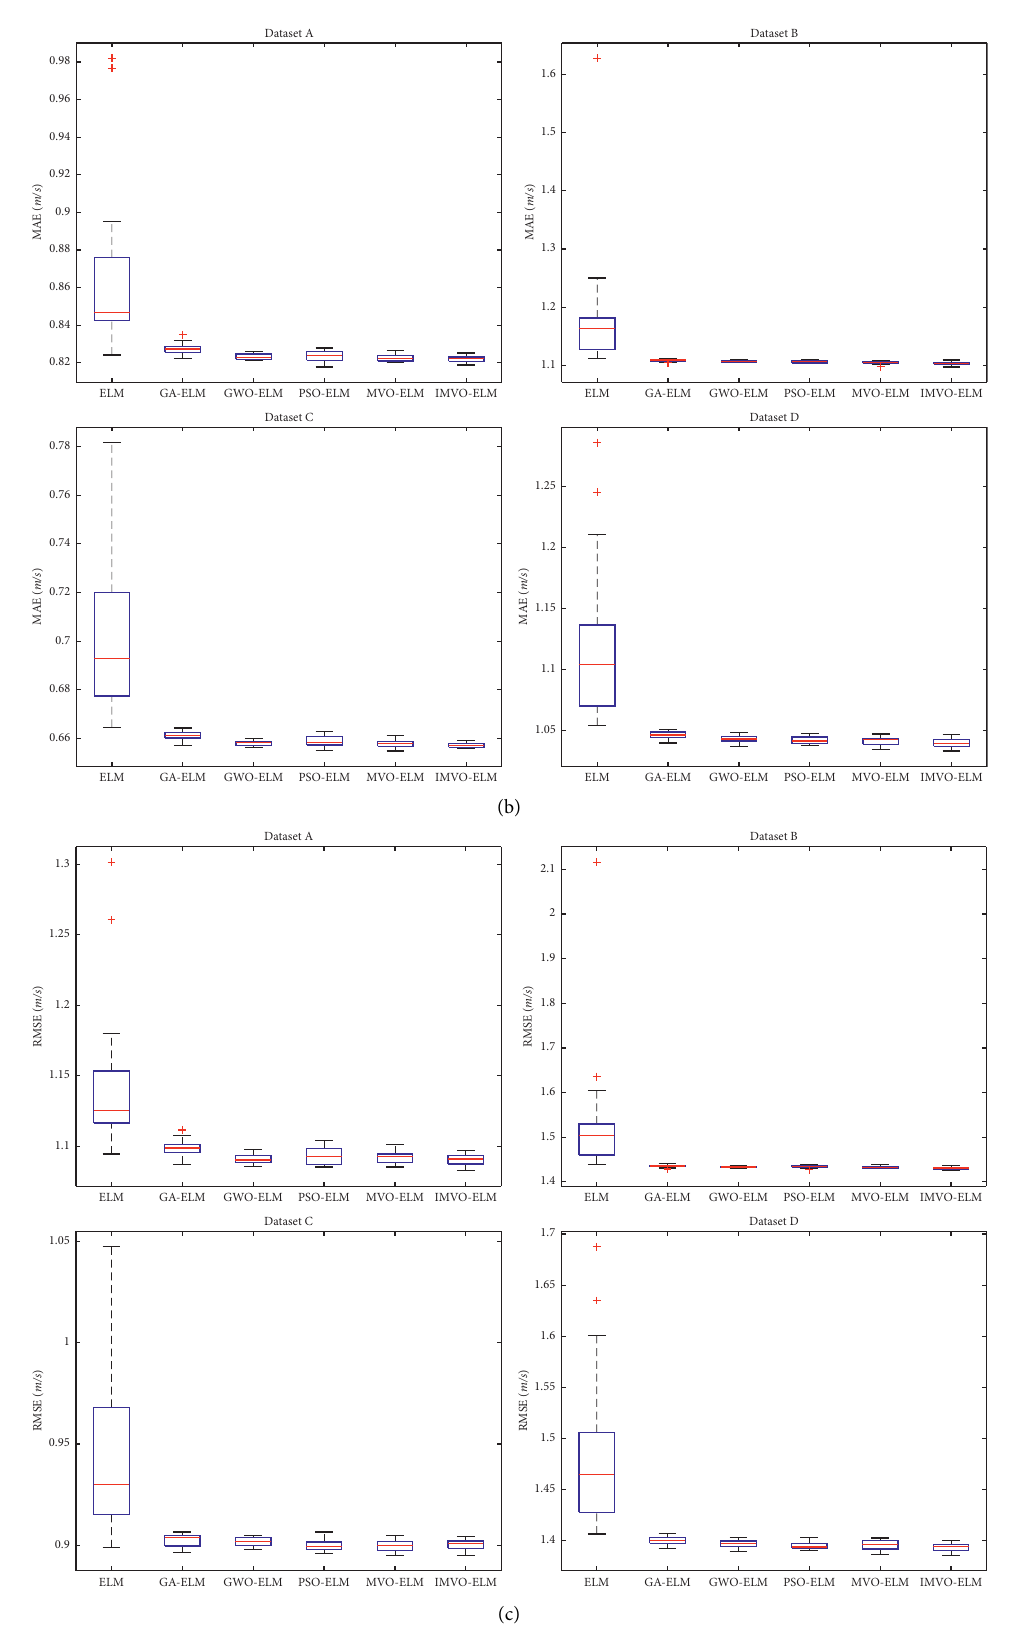
Figure 3: The boxplots of the evaluation metrics of different methods by 20 times’ calculation. (a) The boxplot of MAPE of different methods. (b) The boxplot of MAE of different methods. (c) The boxplot of RMSE of different